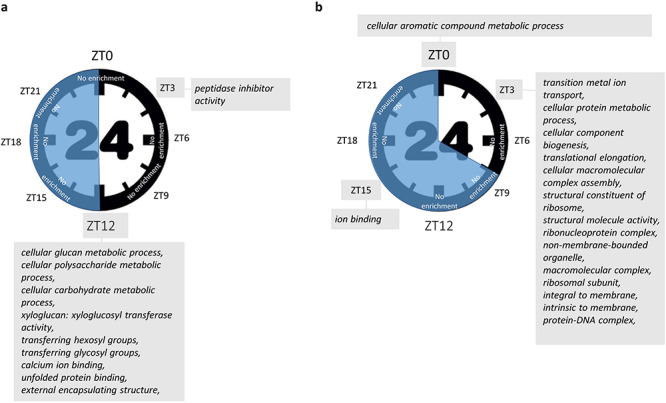
Time-dependent enrichment in functions for both photoperiods. (a) Enrichment GO terms for all DEGs at 12 h/12 h, (b) enrichment GO terms for all DEGs at 8 h/16 h. FDR < 0.05. Photoperiod overexpressed many biological processes as outputs such as cellular aromatic compounds at ZT0 for 8 h/16 h photoperiod or peptidase inhibitor activity for 12 h/12 h photoperiod.